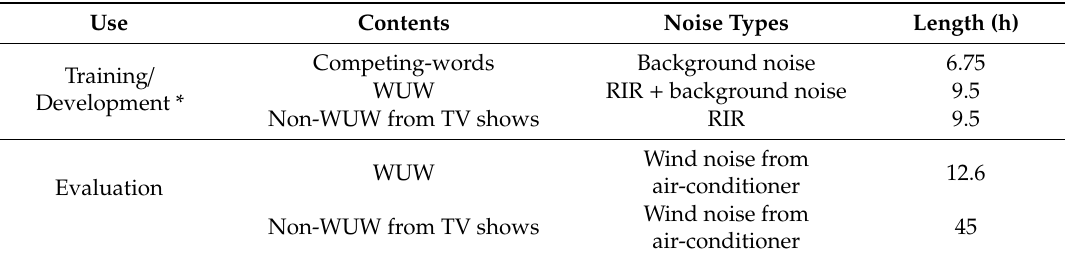
Figure 5. Environment where re-recorded utterances were used for testing. Each point represents the position of the speaker. A combination of distances from an air-conditioner and angles were used. Table 3. Datasets used for the experiments. * A total of 10% of each set of training data was used for the development data with no-overlap with the training